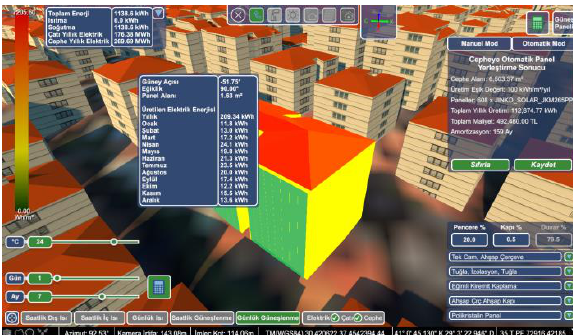
Figure 11. Solar estimation for the selected building façade (potential solar panel).